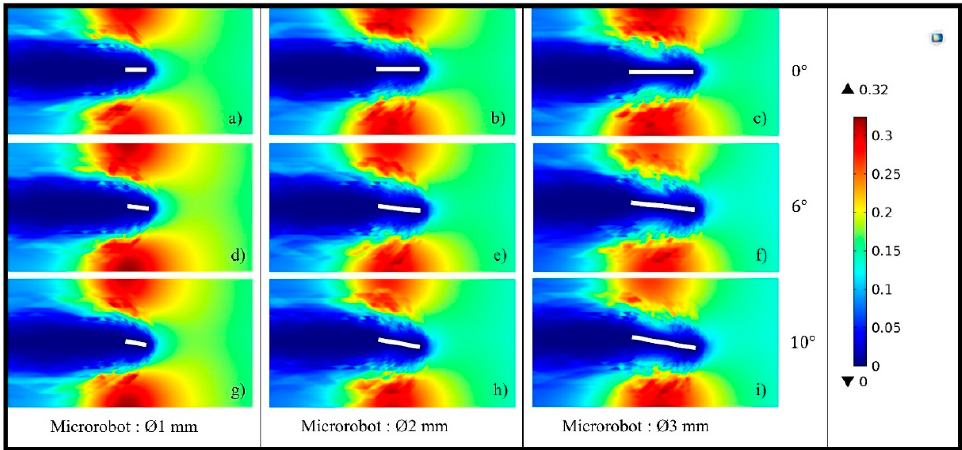
Figure 6. Calculation of Re number is simulated at different head-tilting angles ( 0° ( a , b , c ), 6° ( d , e , f ) and 10° ( g , h , i )) for microrobots with same thickness (200 µm) and different sizes (1 mm (a,d,g), 2 mm (b,e,h), and 3 mm (c,f,i)). COMSOL Creeping Flow analysis is utilized in stationary liquid media. The legend on the right side, as expected, shows that the Re <<1 is not dependent on size and head-tilting angle.